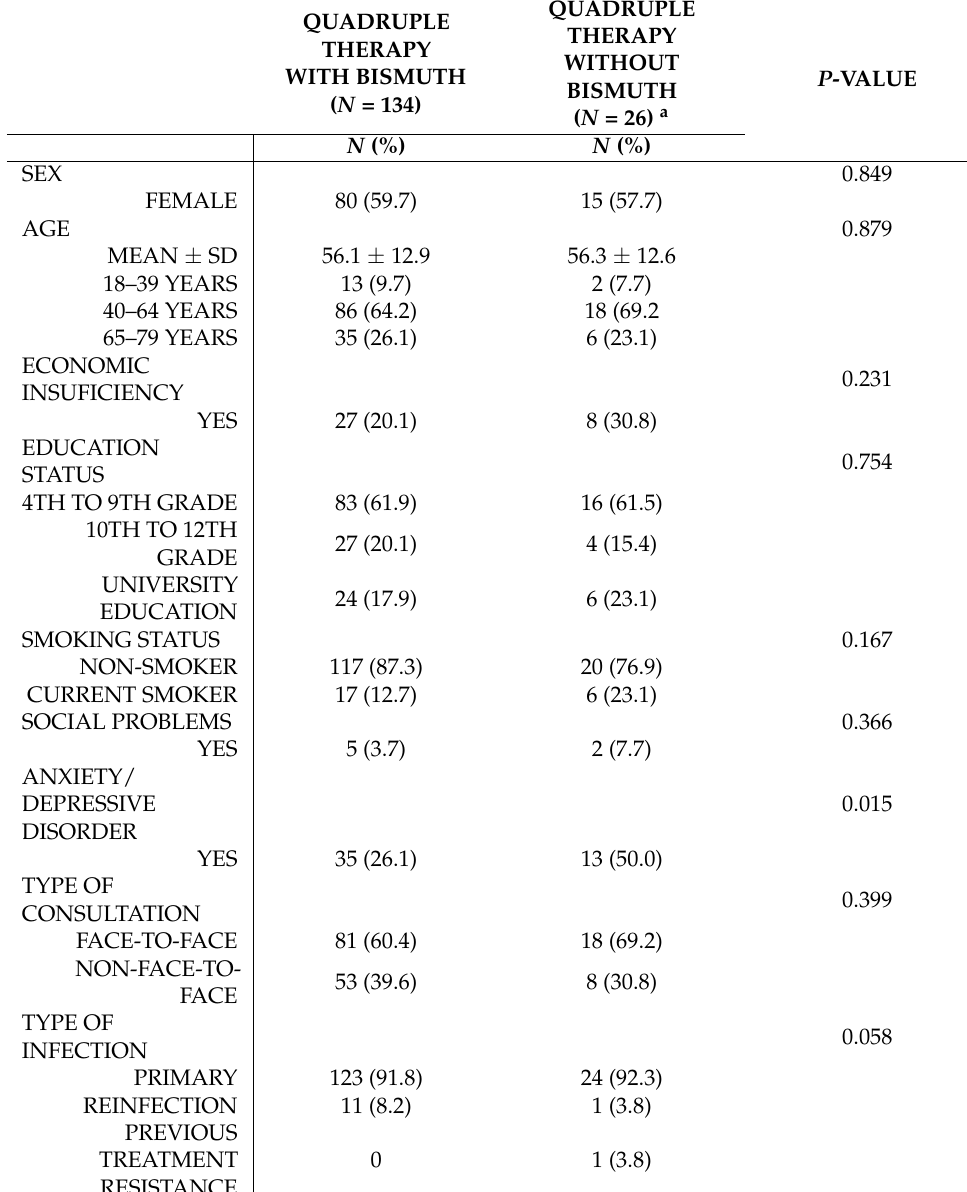
Table 2. Characteristics of the patients in each treatment